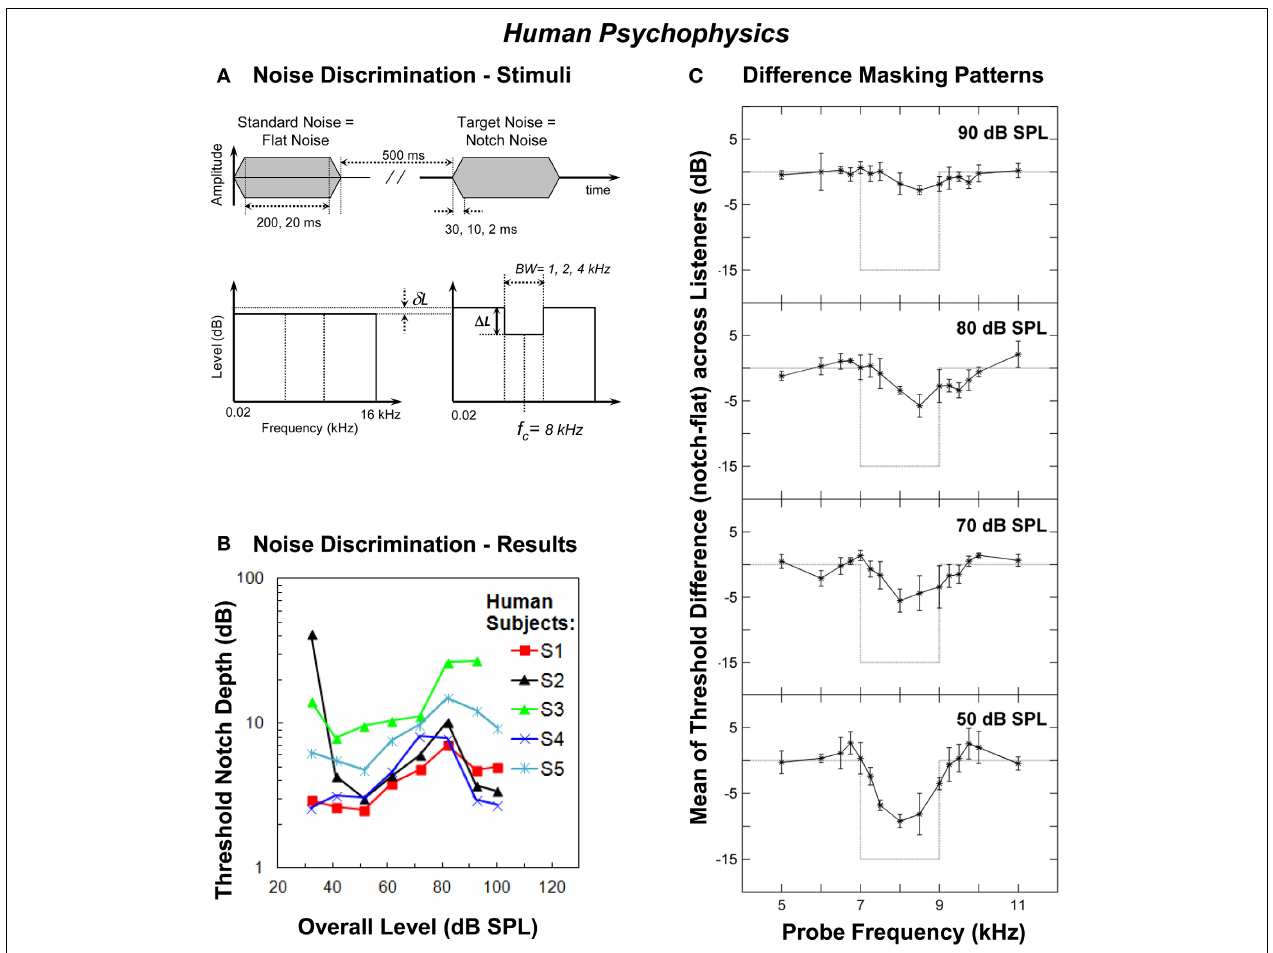
FIGURE 1 | Human psychophysics. (A) Schematic description of the waveforms and spectra of the flat-spectrum (“Standard Noise”) and notch (“Target Noise”) noises used in the noise discrimination experiment. The notch depth ( (cid:2) L ) was defined as the difference in dB between the spectrum level in the notch and the reference spectrum level of the noise in the notch side bands. δ L represents the reduction in spectrum level applied to the standard noise in order to make its overall level equal to that of the target noise. Also indicated are the values of stimulus duration, stimulus on/off time and the notch bandwidth (BW) tested in the experiments (adapted from Alves-Pinto and Lopez-Poveda, 2005). (B) Individual threshold notch depths for discriminating between the standard